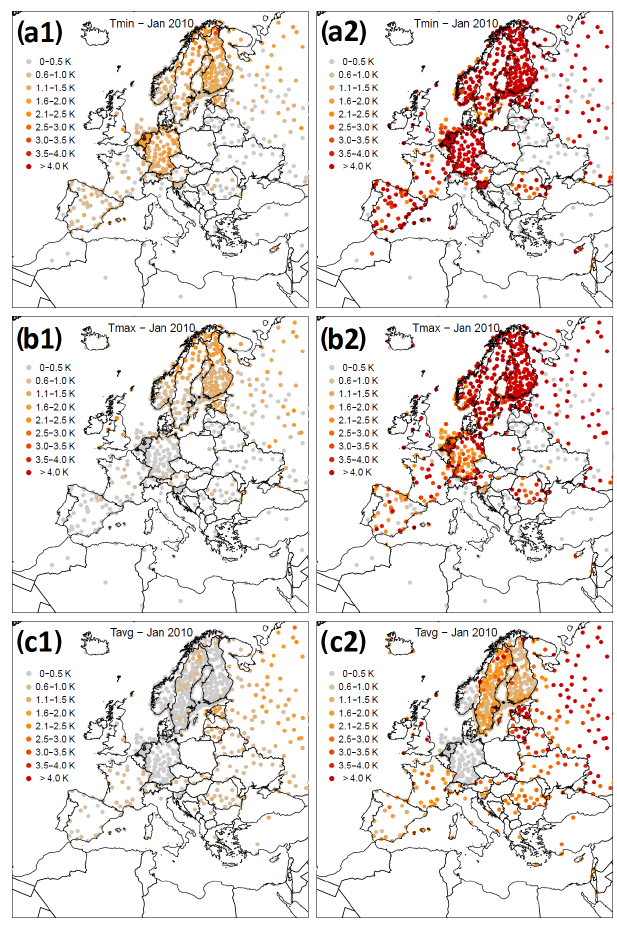
Figure 3. Differences of daily temperature data from SYNOP and ECA&D for January 2010 at stations with identical coordinates. Mean and maximum absolute daily deviation for minimum temper- ature (a1, a2) , maximum temperature (b1, b2) and mean tempera- ture (c1, c2)